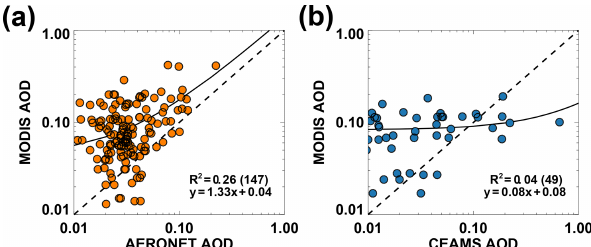
Figure 6. Satellite AOD (MODIS at 550nm) compared to ground- based AOD in northern Colorado measured at (a) AERONET sites (500nm, specific sites used listed in Table S1; n = 94) and (b) CEAMS participant sites (520nm; n = 49) for 28 October– 15 December 2017. Dashed lines are 1-to-1 lines, and the solid lines are linear fits (equations provided in